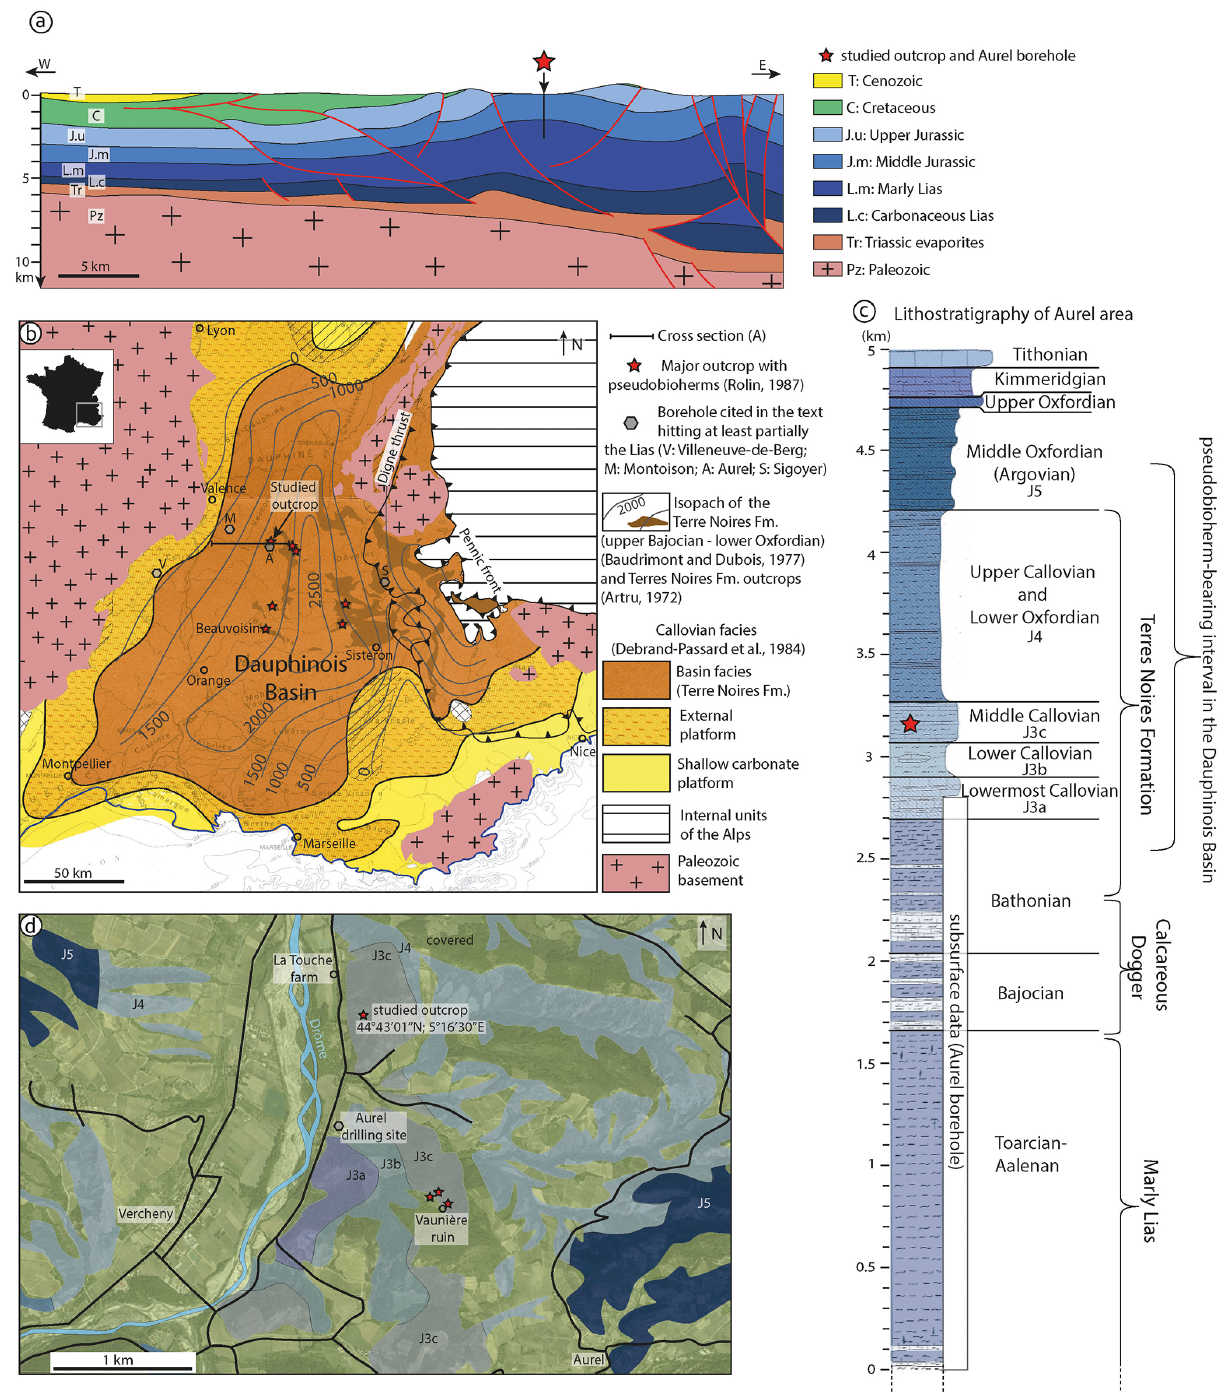
Figure 1. Geological setting of the studied outcrop. (a) Cross section from the margin to the center of the Dauphinois Basin traversing the Aurel borehole (modified after Wannesson and Bessereau, 1999). (b) Facies map of the Dauphinois Basin for the Callovian (Debrand-Passard et al., 1984). Isopachs (in m), after Baudrimont and Dubois (1977), are shown for the basin facies represented by the Terres Noires Formation (middle Bathonian up to lower Oxfordian) in the central part of the basin. Outcrops of the Terres Noires Formation (after Artru, 1972) are noted by a darker shade of brown, and the locations of major pseudobioherms are marked by red stars (after Rolin, 1987). (c) Lithologic log of the Aurel area (Flandrin, 1974). The Aurel borehole penetrated the carbonate-dominated Dogger and the marly upper Lias. The pseudobioherms in the Aurel area are hosted in middle-Callovian sediments (red star on the log); in the Dauphinois Basin, they generally occur in upper-Bathonian to middle-Oxfordian deposits. (d) Geological map of the Aurel area (modified after Flandrin, 1974). Several pseudobioherms are poorly exposed near the Vaunière ruin; the studied pseudobioherm is located near La Touche farm. https://doi.org/10.5194/se-12-2439-2021 Solid Earth, 12, 2439–2466,